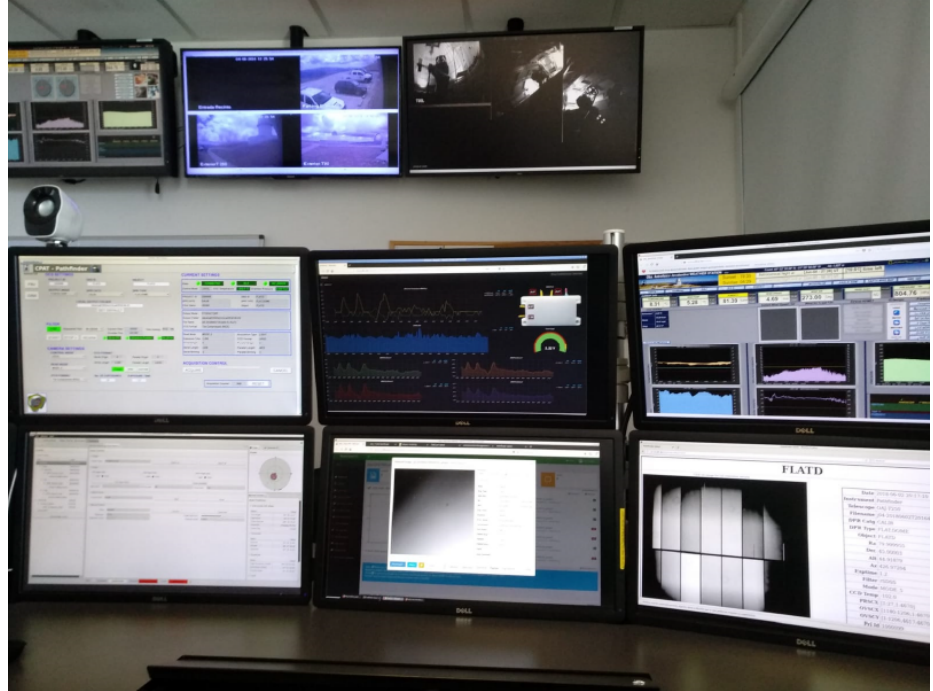
Figure 16. Monitoring